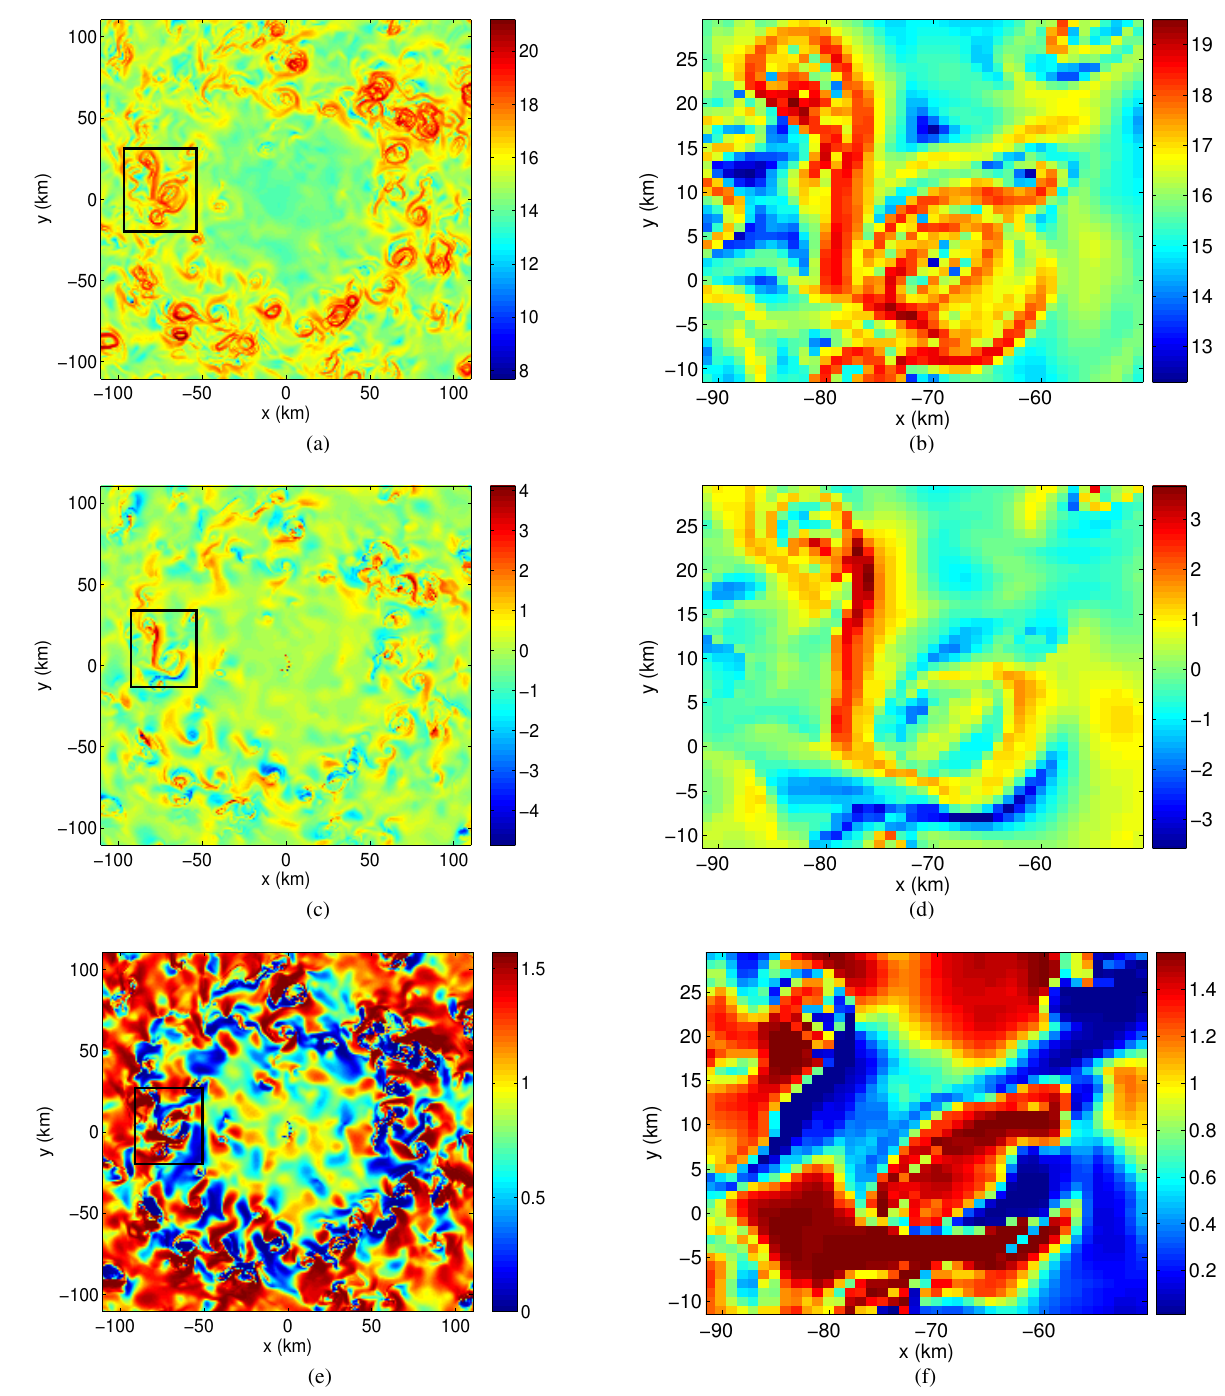
Fig. 3. Planar FTLE, Ψ 22 , and ϕ fields in (a), (c), and (e) respectively, at initial time of 10 hours with integration time of 1 hour at 1 km height. A zoom into a particular structure from the boxes in (a), (c), and (e) are shown in (b), (d), and (f).